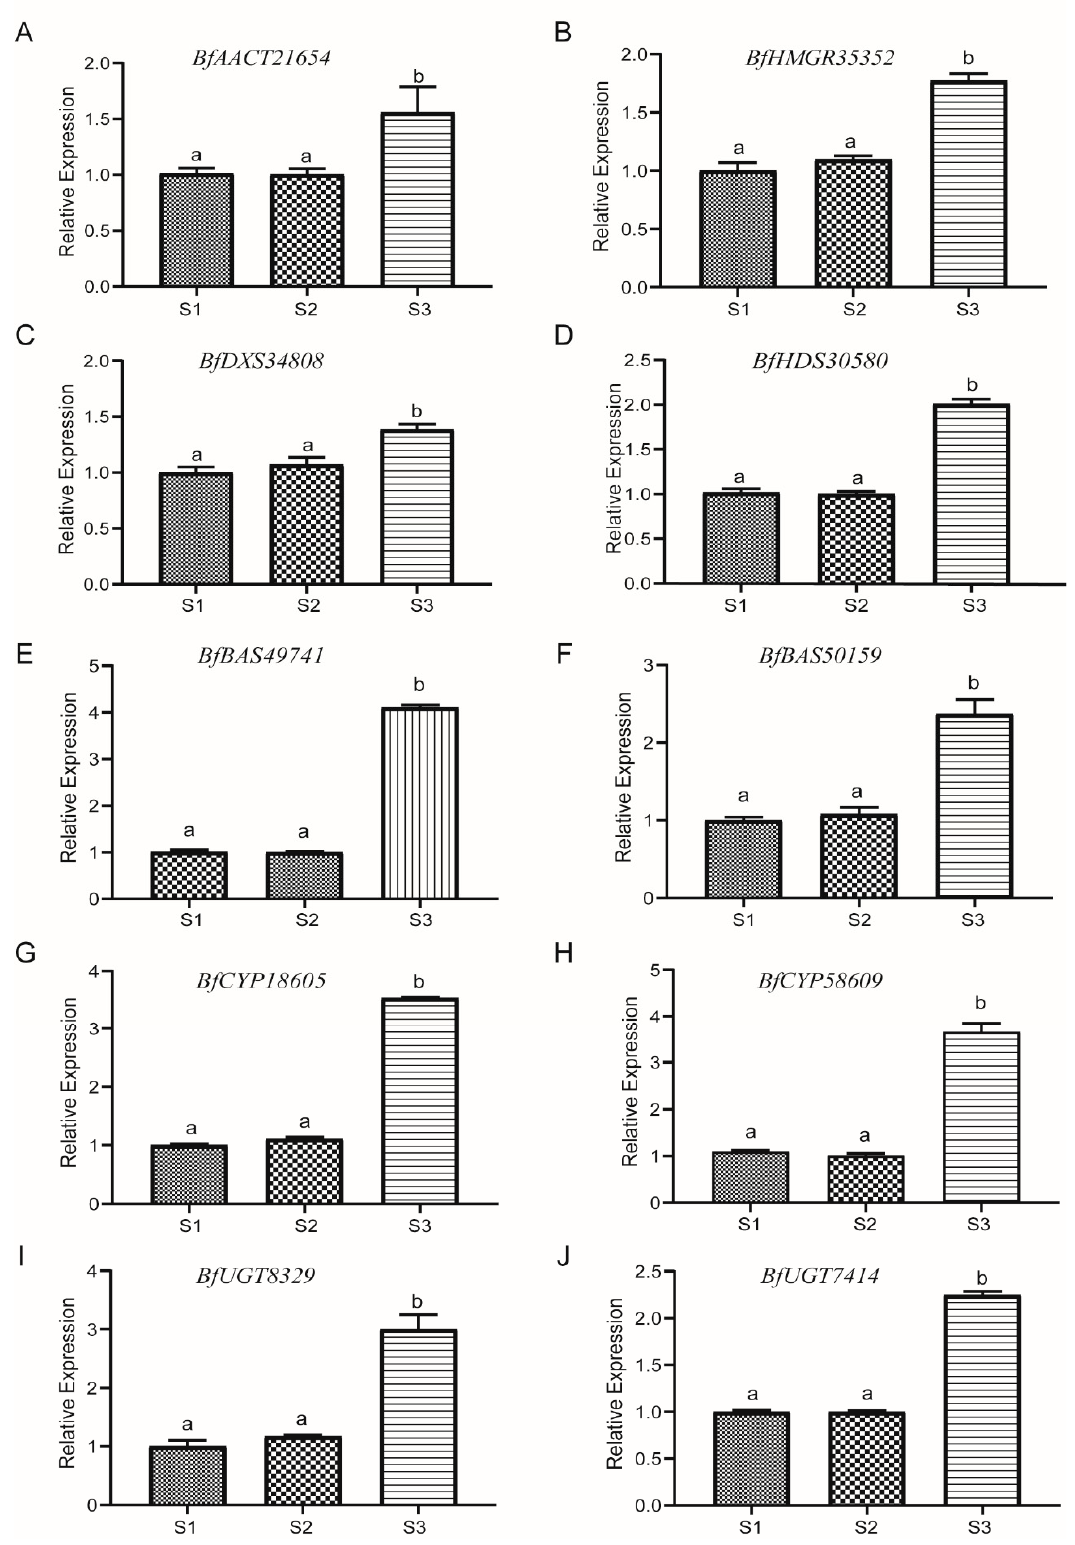
Figure 6. qRT-PCR verification of key genes of saikosaponin biosynthetic pathway. ( A–J ) The relative expression patterns of BfAACT21654, BfHMGR35352, BfDXS34808, BfHDS30580, BfBAS49741, BfBAS50159, BfCYP18605, BfCYP58609, BfUGT8329 and BfUGT7414 . The bar represents the standard error (SE). Data are presented as mean ± SE. Different letters represent different levels of significant